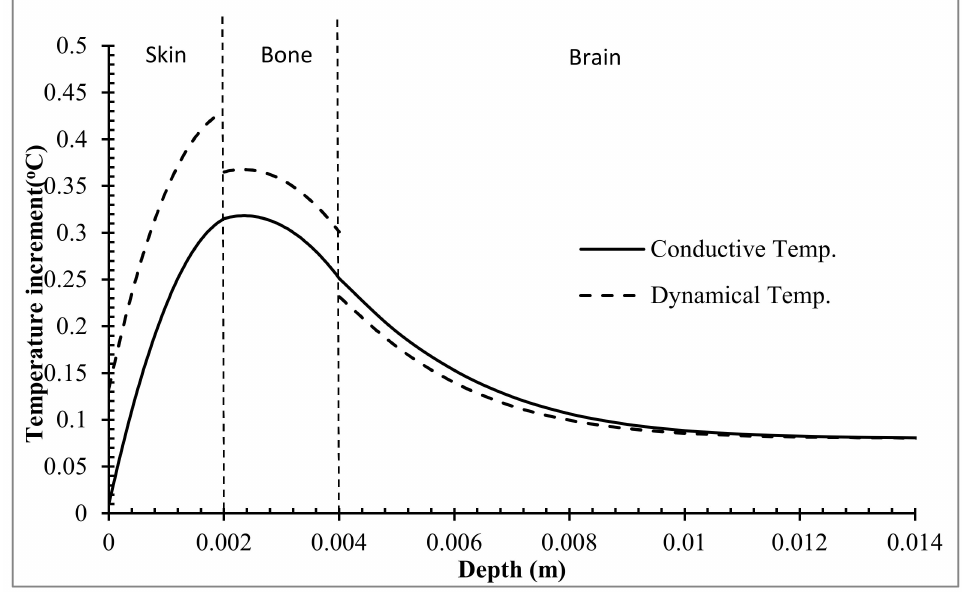
Figure 3. The conductive and dynamical temperature increment on a child’s